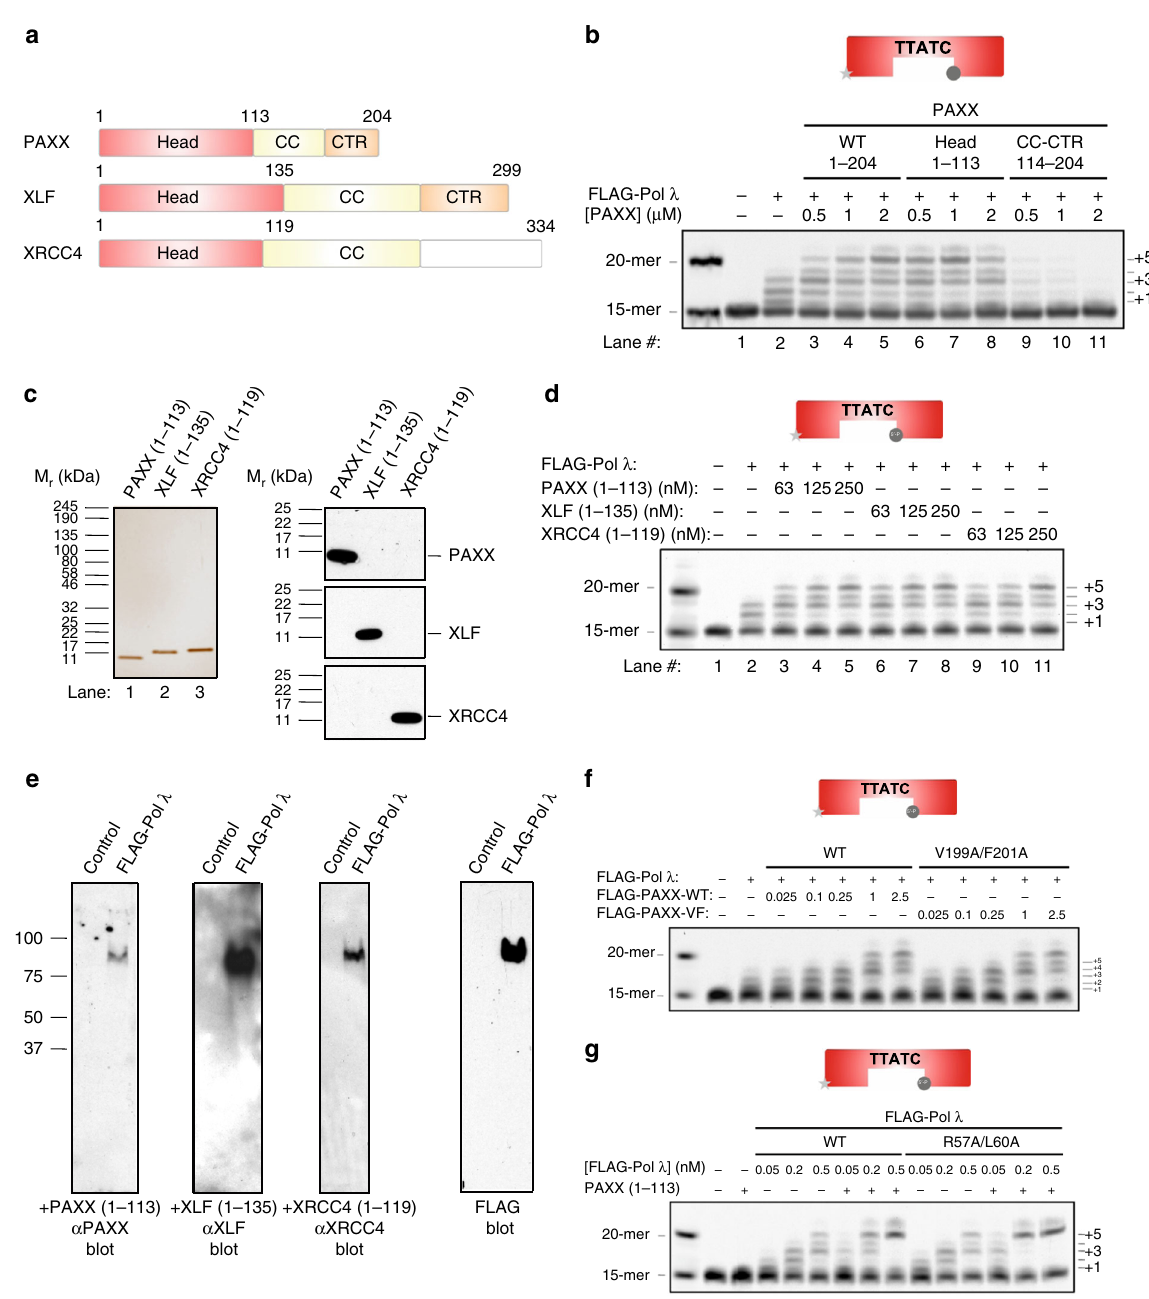
Fig. 7 Head domains of XRCC4 Family Proteins interact with and stimulate Pol λ -dependent gap fi lling synthesis. a Schematic representation of XRCC4 family proteins. b PAXX head domain, but not the CC-CTR region, stimulates gap fi lling synthesis activity of Pol λ . c Silver stain and immunoblot analysis of puri fi ed XRCC4 family protein head domains. d Head domain of XRCC4 family proteins stimulate Pol λ -dependent gap fi lling synthesis activity. e Far- Western blot analysis showing that Pol λ -WT interacts with the head domain of XRCC4 family proteins. f Stimulation of Pol λ -dependent gap fi lling synthesis activity by PAXX-WT but not PAXX-VF, a non-Ku binding C-terminal mutant. g PAXX head domain stimulates comparable gap fi lling synthesis activity of Pol λ -WT and –